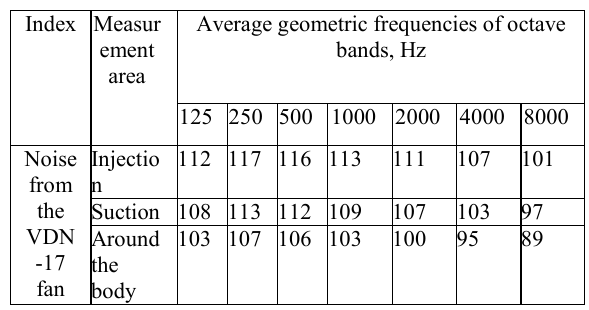
Table 3. Frequency response of noise from VDN-17